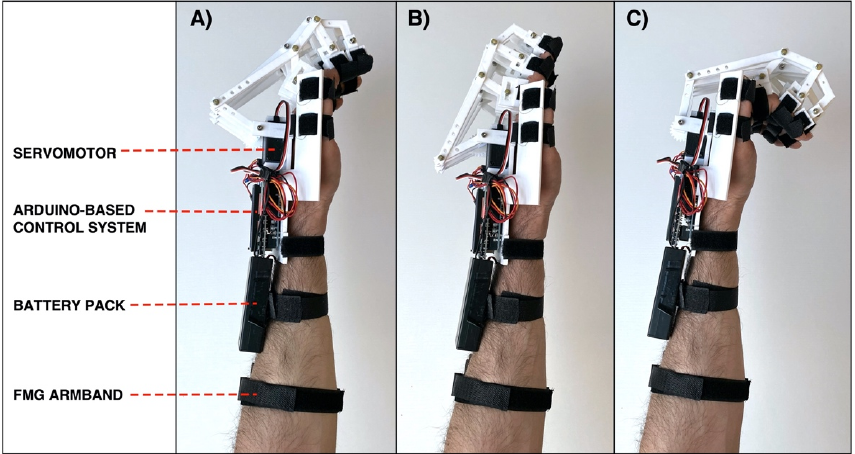
Figure 5. Side view in different exoskeleton positions: ( A ) at rest; ( B ) finger extension (open hand); ( C ) finger flexion (closed hand).